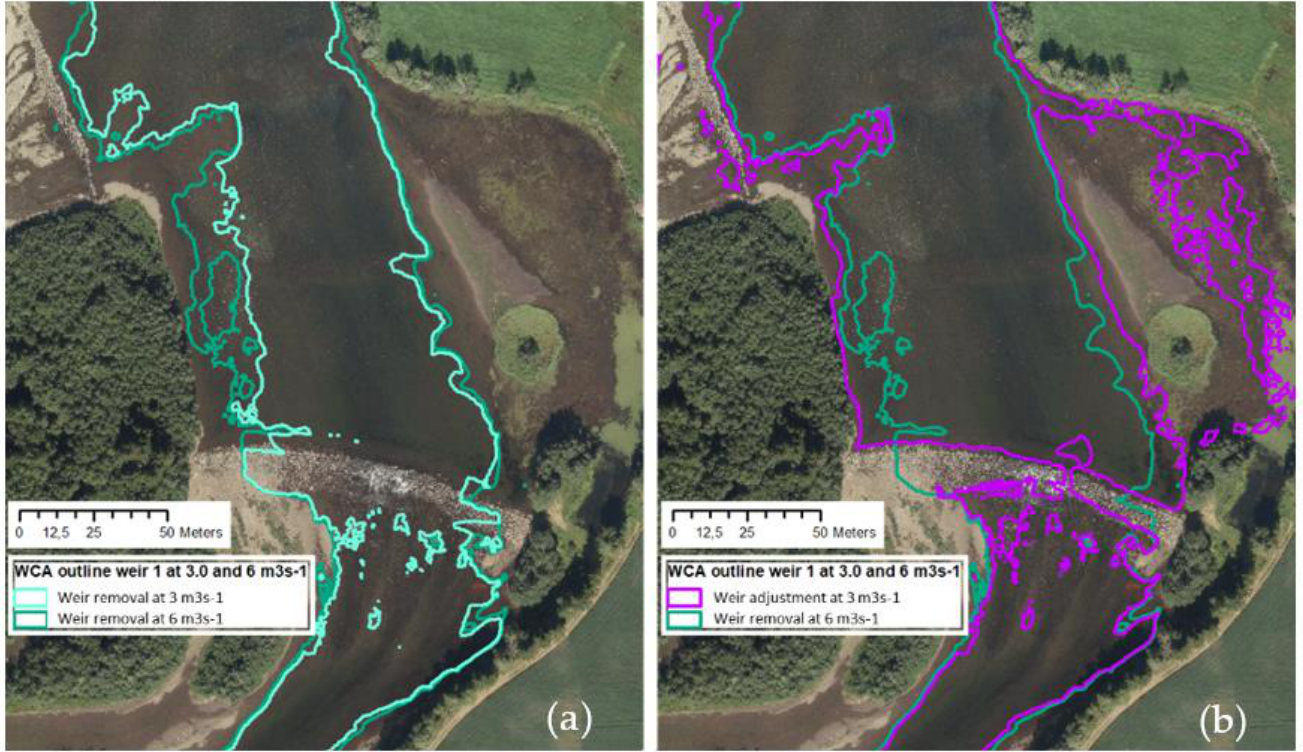
Figure 9. Example of the effect of weir adjustment and removal on the water-covered area for weir no. 1 at flows 3 and 6 m 3 /s. ( a ) WCA outline for full weir removal simulated at flows of 3 m 3 /s (light green) and 6 m 3 /s (dark green). ( b ) WCA outline for weir adjustment at 3 m 3 /s (purple) and weir removal at 6 m 3 /s (dark green). As shown in ( b ), doubling the flow to 6 m 3 /s with weir removal compensates for a large proportion of the WCA for weir adjustment at a flow of 3 m 3 /s.